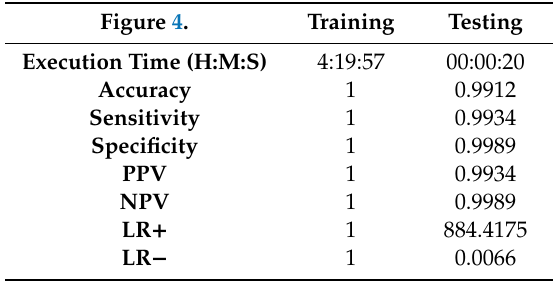
Table 5. Comparison between twenty subjects using CNN for Training and Testing approaches. Figure